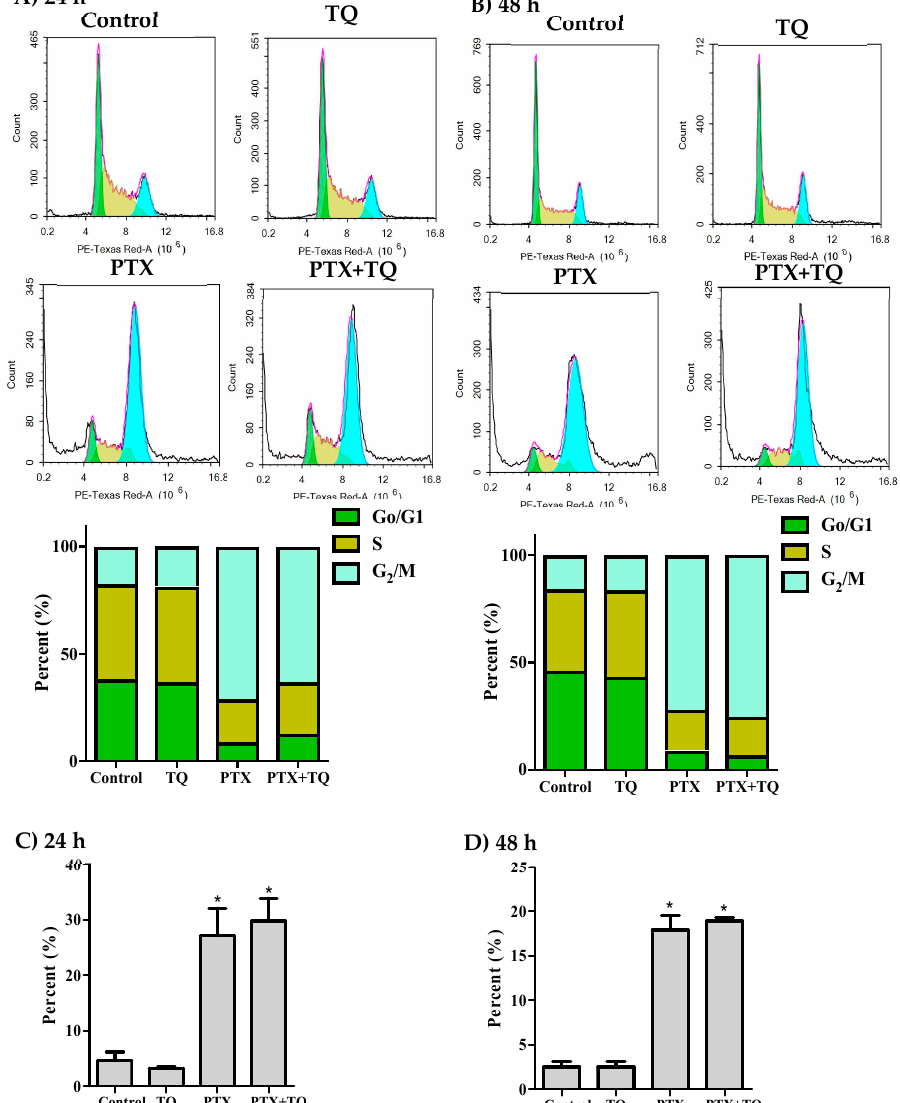
Figure 2. Effect of PTX, TQ, and their combination on the cell cycle distribution of MCF-7 cells. Cells were exposed to PTX, TQ, or their combination for 24 h ( A , C ) or 48 h ( B , D ). Cell cycle distribution was determined using DNA content flowcytometry analysis and different cell phases were plotted as percentage of total events. Sub-G cell population was plotted as percent of total events ( C , D ). Data are presented as mean ± SD; n = 3. (*) significantly different from the control group.